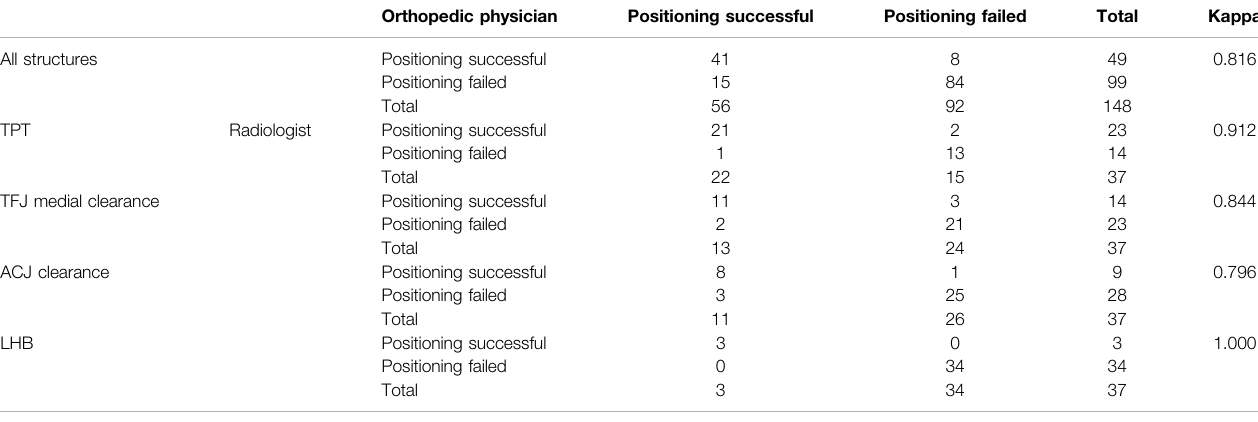
TABLE 2 | Evaluation of palpation results by rotating physicians and Kappa analysis.